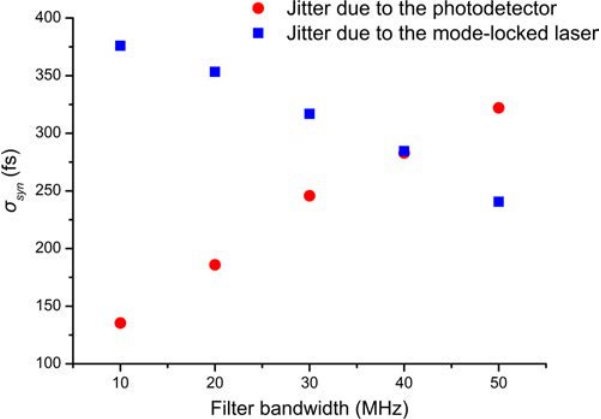
Fig. 5. Relative timing jitter as a function of the RF ¯lter bandwidth. The relative timing jitter is caused either by the 400-fs photodetector induced electrical jitter (red circles), or by the 400-fs mode-locked laser intrinsic timing jitter (blue squares). Each data point is the average of ten successive